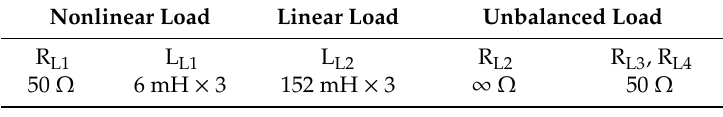
Table 1. Load parameters for simulation scenario.